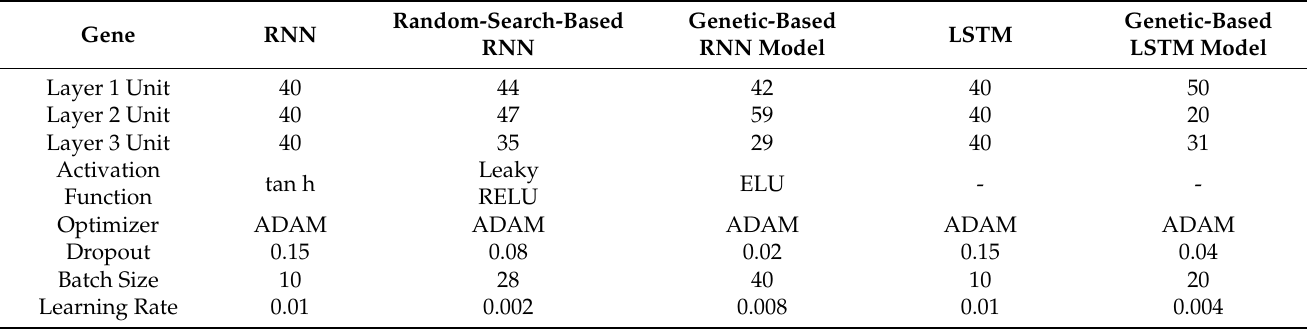
Table 5. Performance comparison of existing deep learning models and optimized deep learning